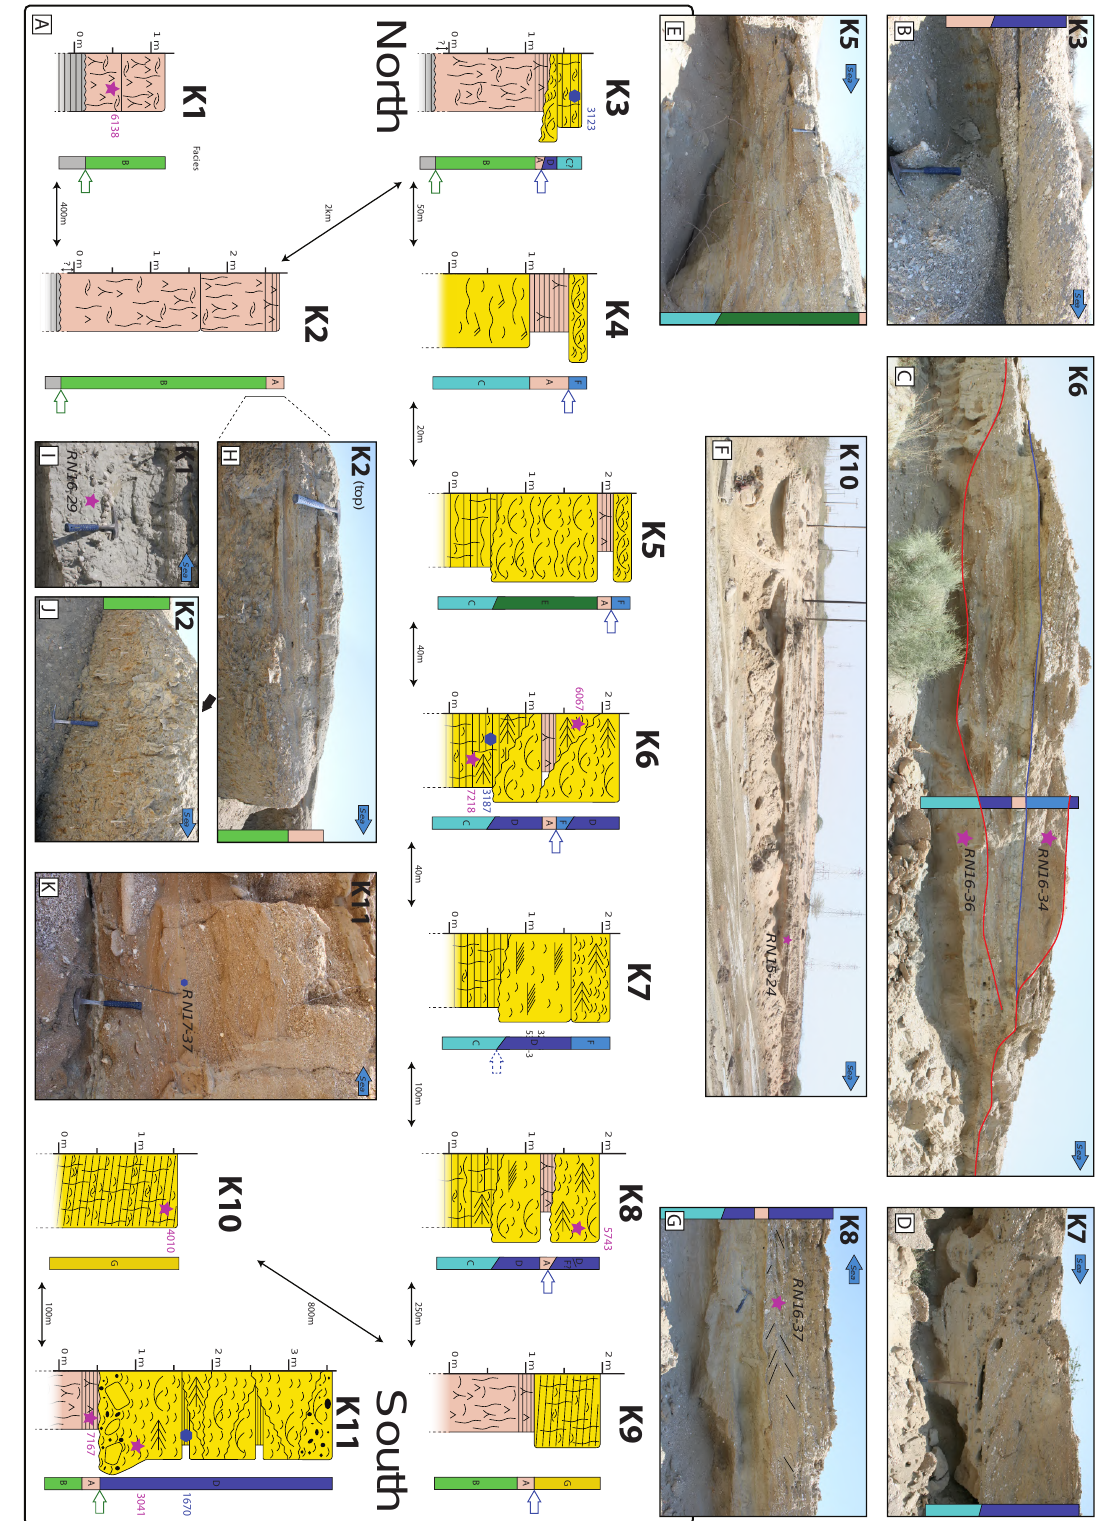
Figure 7. Stratigraphic logs of Konarak Airport section (K1–K11). Facies lettering is as reported in Table 3. Vertical scale is not absolute altitude, but height above the bottom of the channel. Blue outlined arrow: Flooding surface (see Section 4.3.2). Gree n arrow: Mid-Holocene transgression. More field pictures can be found in the data repository [56], images